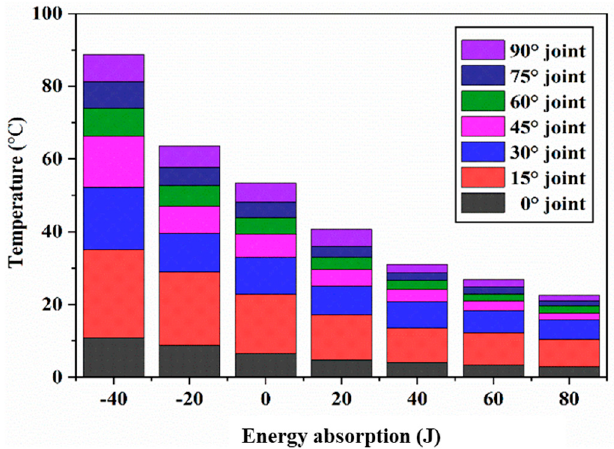
Figure 14. Joint energy absorption histogram as a function of